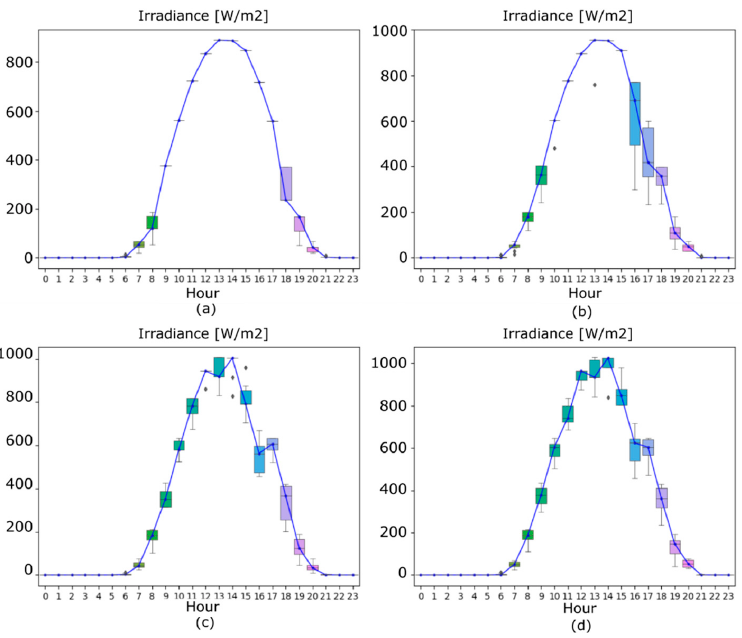
Figure 7. Median scenarios (blue) with box-whisker plot for scenarios generated for July using n S = 1000, n P = 10, and metric = l 2 -Norm without outlier removal and varying the number of regions ( n R ): 3 ( a ), 5 ( b ), 11 ( c ), and 21 ( d ).